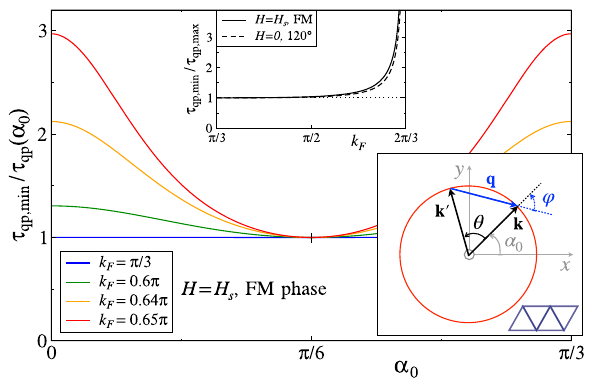
FIG. 16. We show 1 = τ vs α 0 for H ¼ H normalized to its s qp value at α 0 ¼ π = 6 for the parameters in Table I and several values π = 6 Þ = τ 0 Þ for the FM state (solid line) of k . Upper inset: τ F qp ð qp ð and 120° state (dashed line) vs k . Right inset: scattering F diagram, angles, and laboratory axes, cf. Fig.